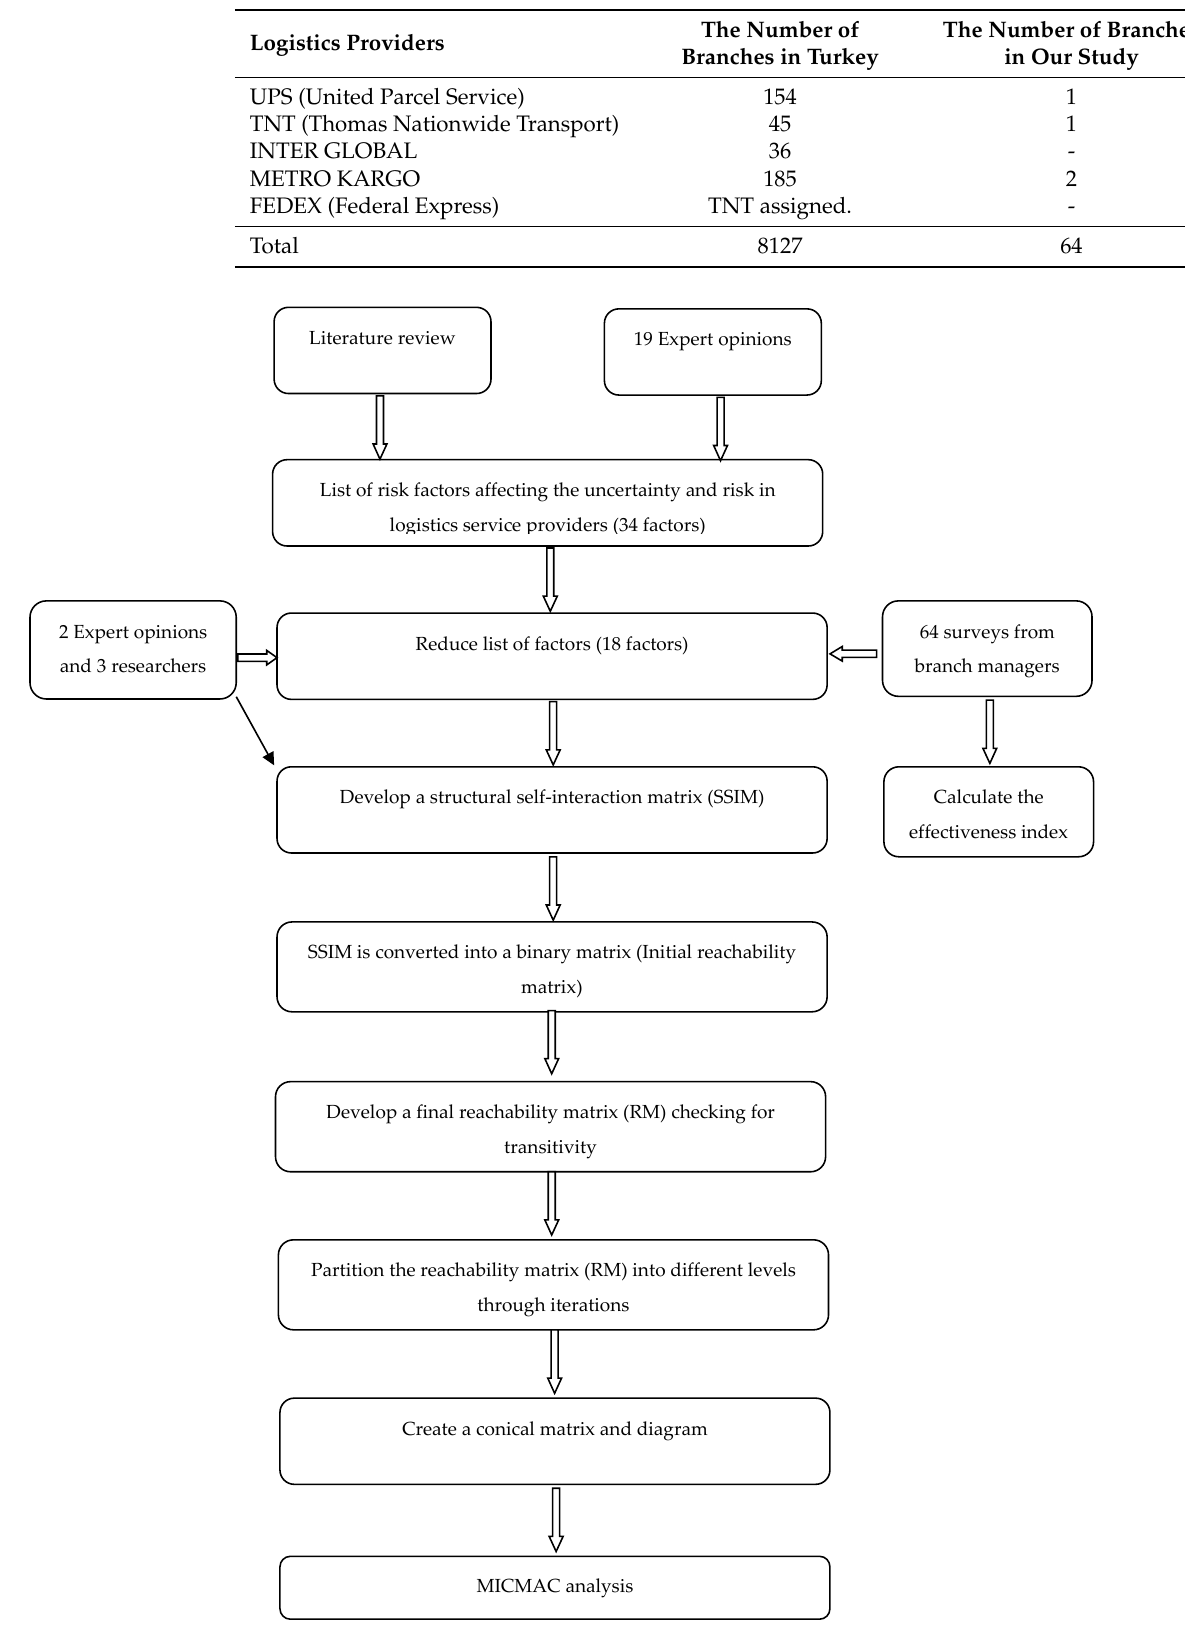
Figure 1. Flowchart for ISM.